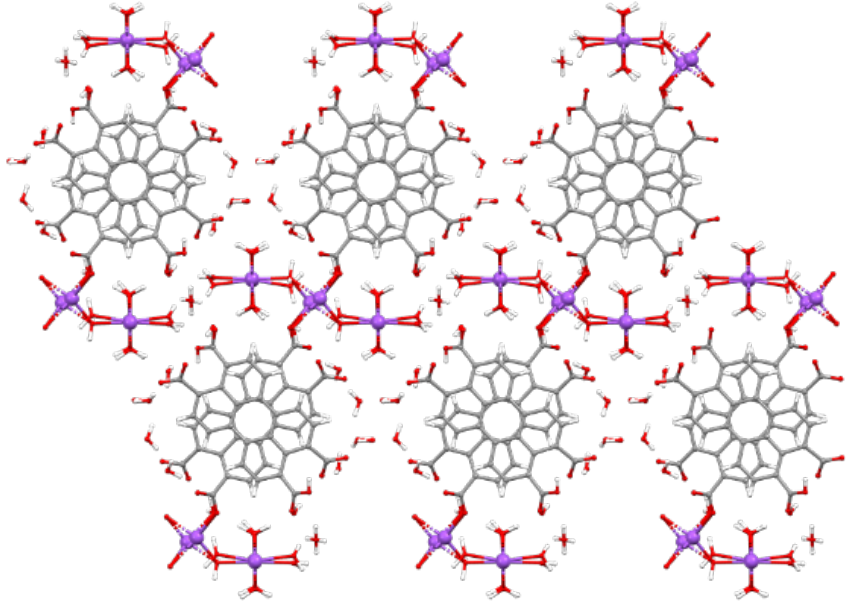
Figure 4. View down the a axis of Na-Pery. Color code: H = white, O = red, C = grey, Na = purple.